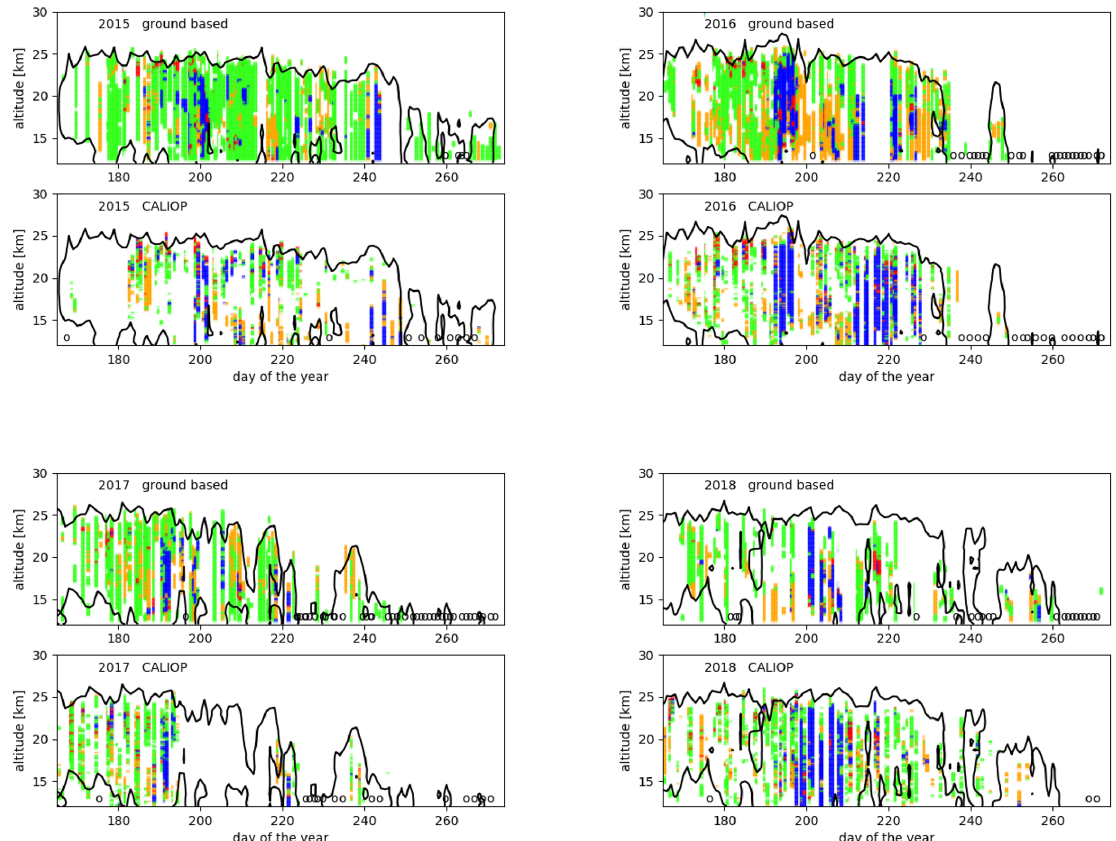
Figure 8. All PSC observations for 2015–2018 above Dome C. Upper panels show ground-based lidar. Lower panels show CALIOP above Dome C. The different colors indicate classified PSCs. Green: NAT mixtures; yellow: STS; red: enhanced NAT mixtures; blue: ice. The circles indicate measured profiles without PSCs. The black contour indicates the area with a temperature below T NAT